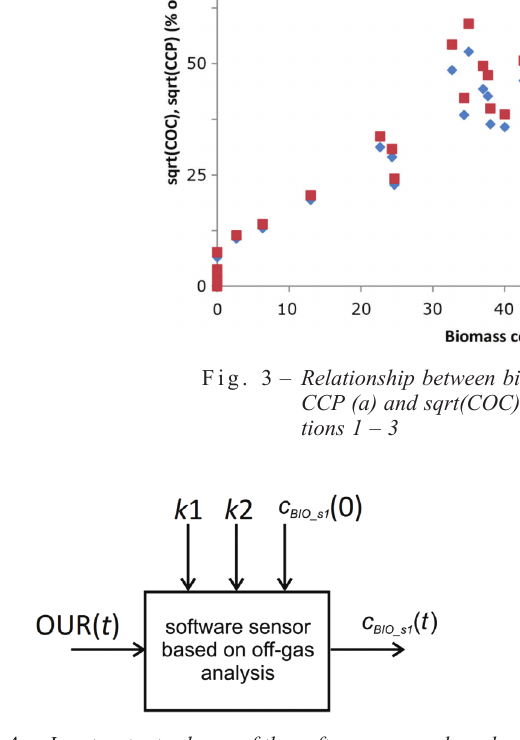
Fig. 4 – Input-output scheme of the software sensor based on off-gas